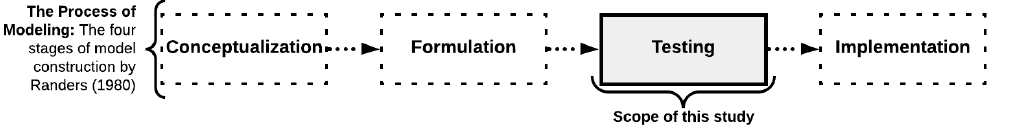
Figure 4. The Randers’ modeling